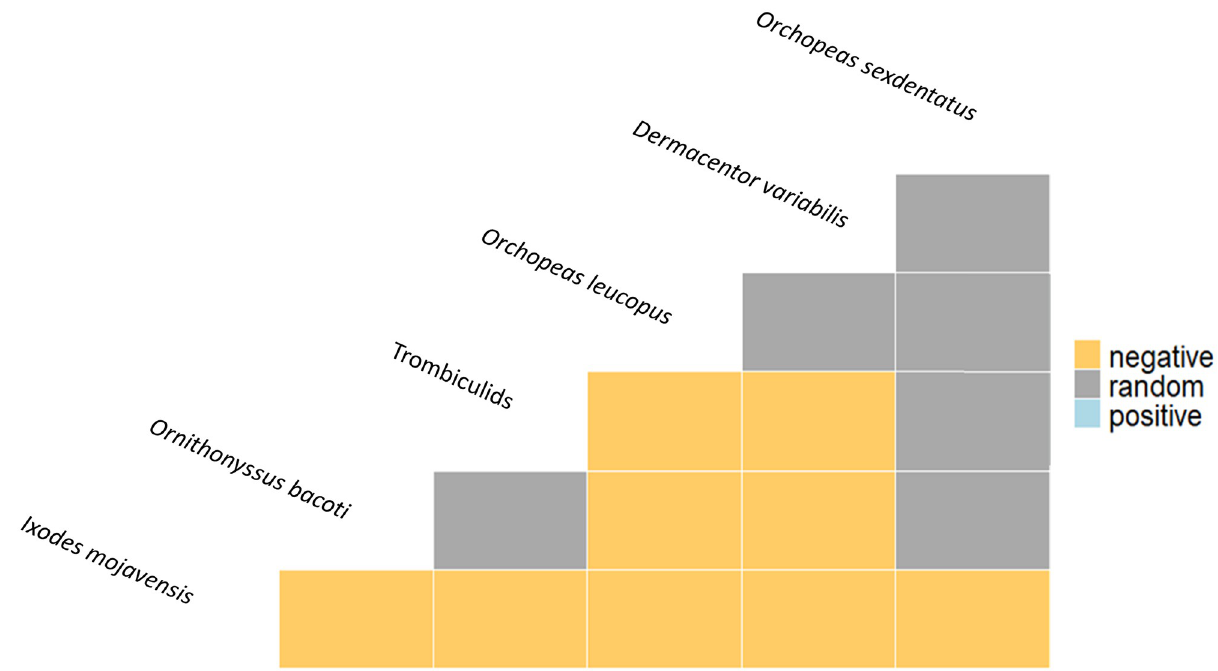
Fig 4. Taxon co-occurrence matrix for all possible pairwise comparisons between mites, fleas and ticks collected from rodents in Tecopa, California,